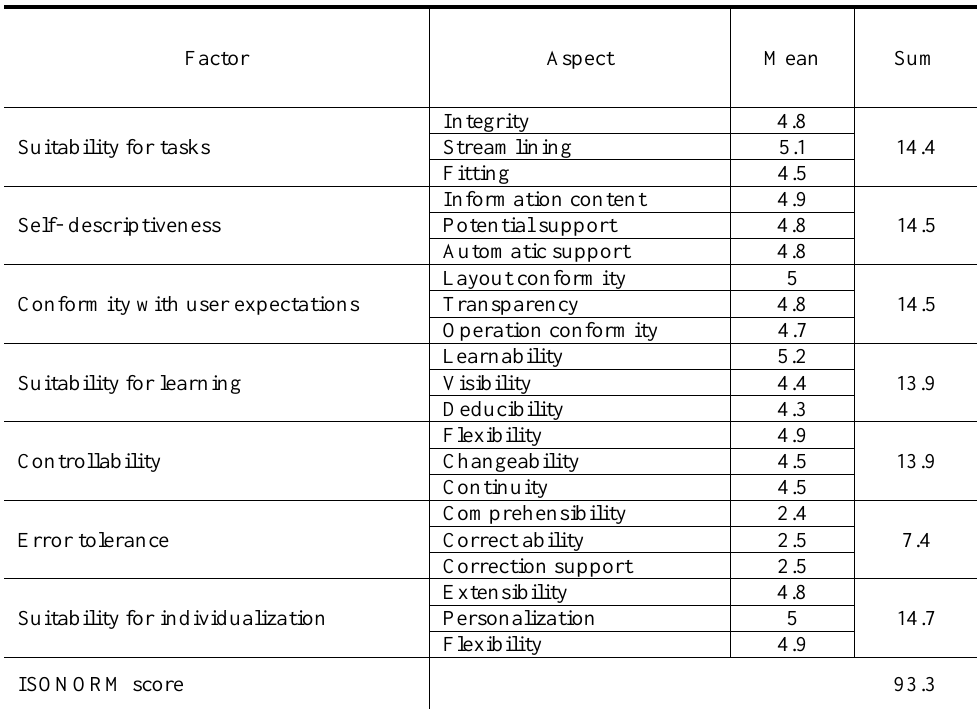
ISONORM 9241/110-S Evaluation Matrix (N= 50)